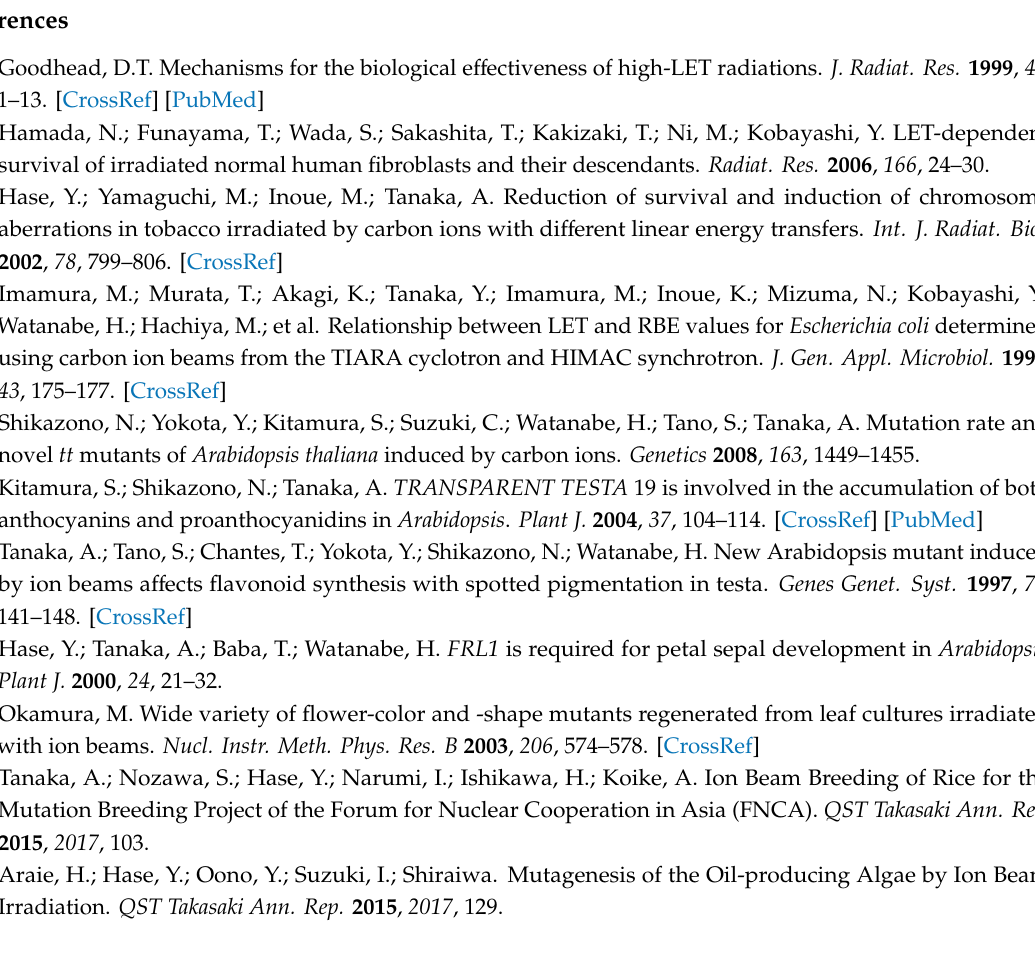
Table S1. Primers used in this study, Table S2. DNA sequence context of mutations among carbon ion beam irradiation mutations in ura3 of rad52 -type. Box indicates that the sequence “3’-ACA-5” or “3’-TGT-5” changed. Underline indicates the position of mutation, Table S3. DNA sequence context of mutations among carbon ion beam irradiation mutations in ura3 of ogg1 -type. Open box indicates that the sequence “3’-ACA-5” or “3’-TGT-5” changed. Underline indicates the position of mutation, Table S4. DNA sequence context of mutations among carbon ion beam irradiation mutations in ura3 of msh2 - type. Open box indicates that the sequence “3’-ACA-5” or “3’-TGT-5” changed. Underline indicates the position of